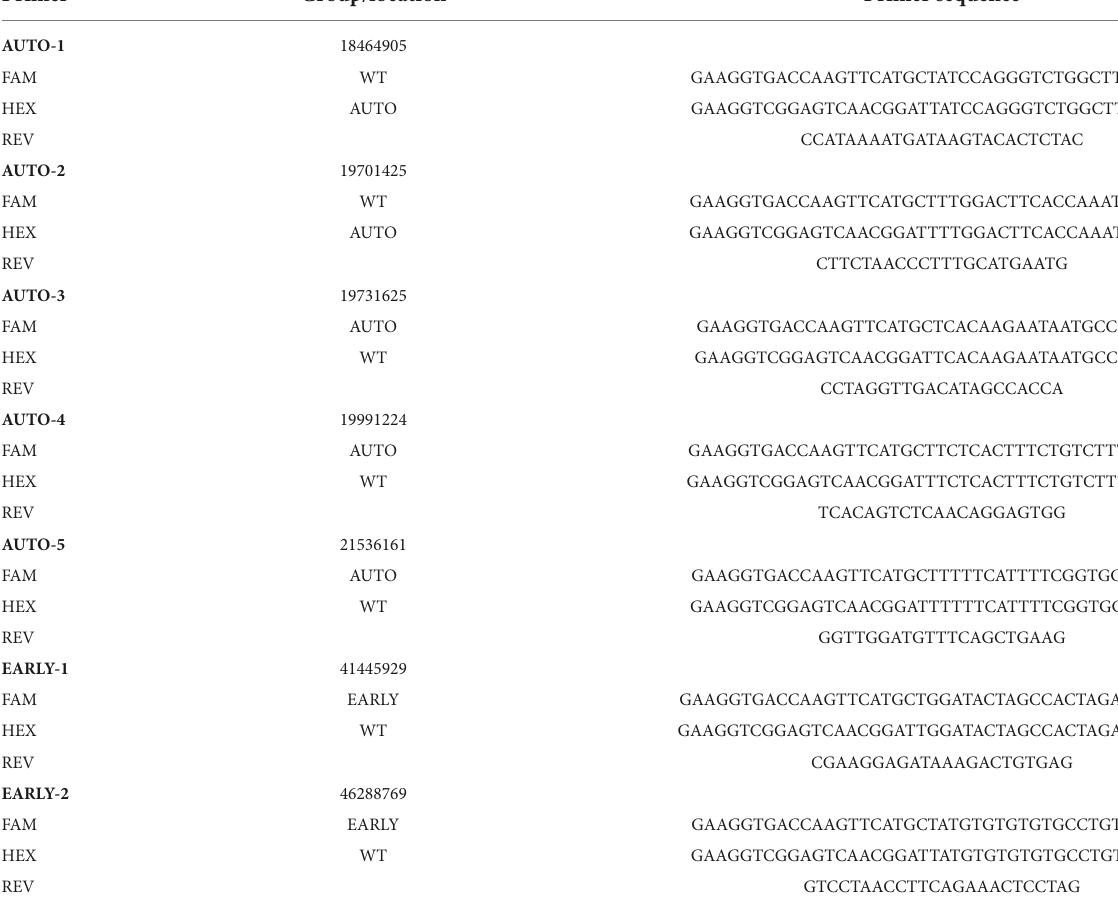
TABLE 1 PACE primers designed for the Autoflower1 (AUTO) and Early1 (EARLY) loci. Group/location Primer